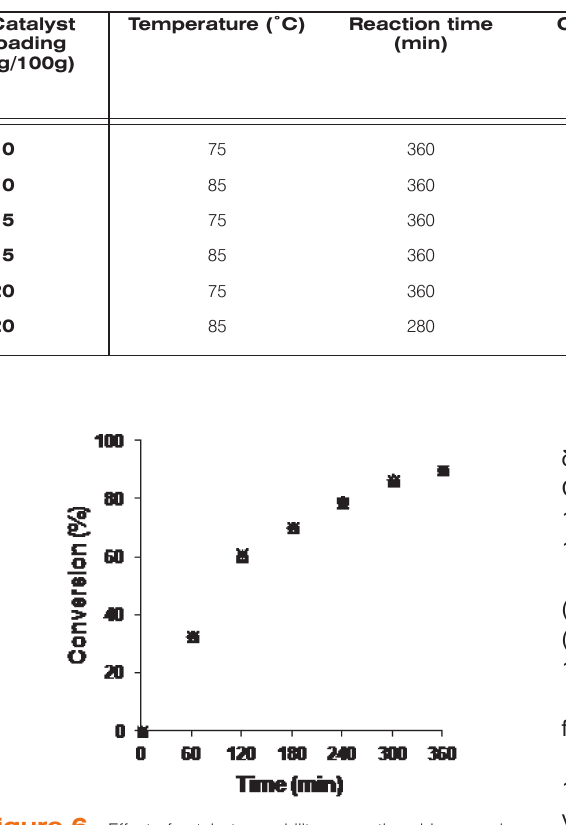
Figure 6. Effect of catalyst reusability on acetic acid conversion; + fresh catalyst, ○ first reuse, ∆ second reuse, ◊ third reuse , x fourth reuse; molar ratio acetic acid – epichlorohydrin 1:1.15; stirring speed 500 r.p.m.; catalyst loading 15 g catalyst per 100 g reaction mixture; temperature